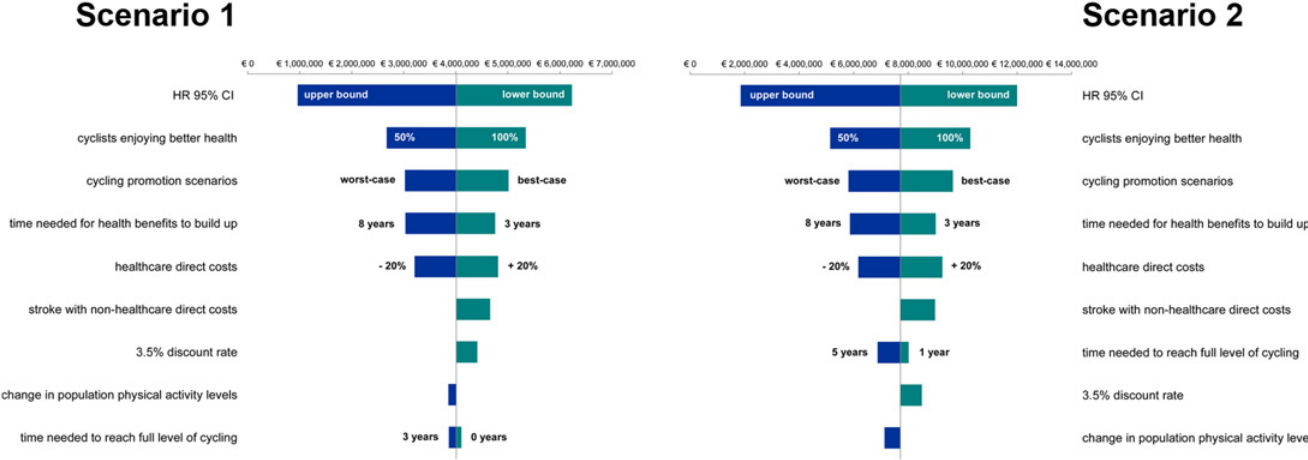
Fig 5. Discounted savings over a 10-year period (2013 – 2022) — Sensitivity analyses ’ results. Scenario 1: Less ambitious cycling promotion target; Scenario 2: Optimistic cycling promotion